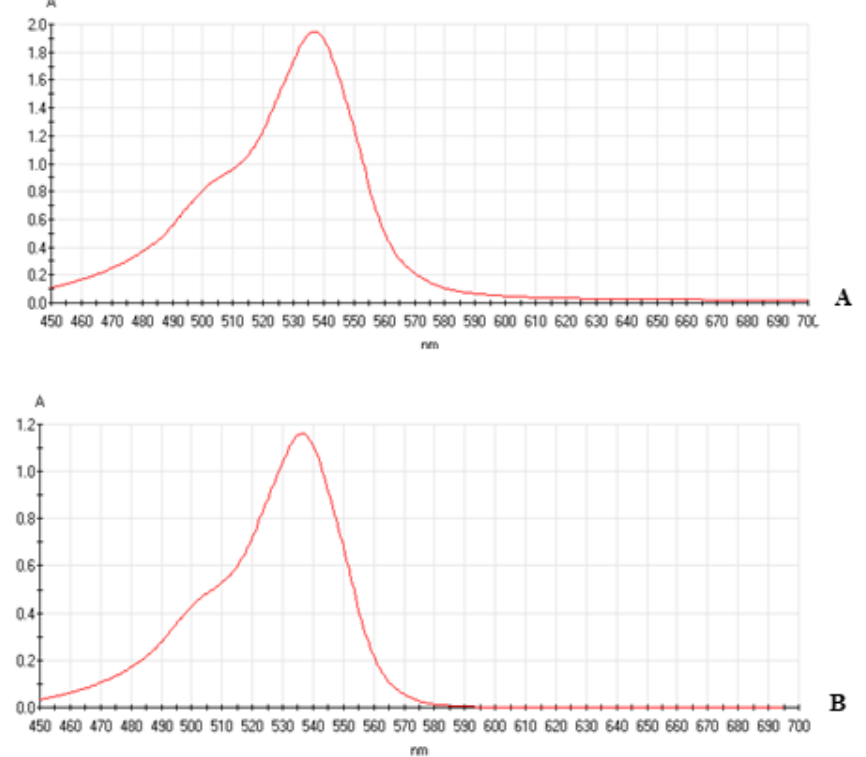
Figure 1. Visible adsorption spectra (range: 450-700 nm) of purified prodigiosin obtained from peptone-glycerol medium (A) and peanut broth (B) .